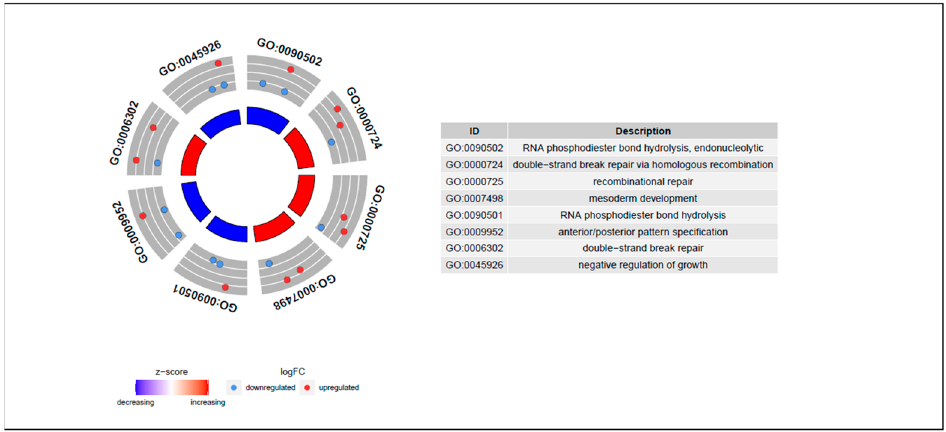
Figure 6. GO items of the driven genes.